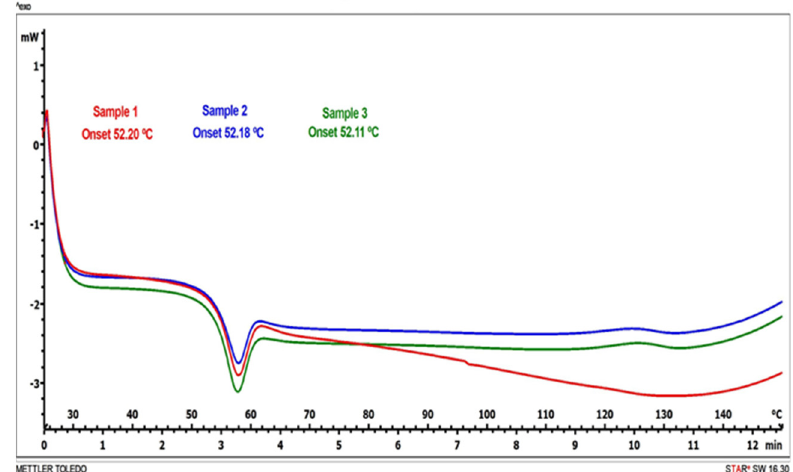
Figure 7. Thermograms obtained by DSC of lyophilized samples (3 replicates).